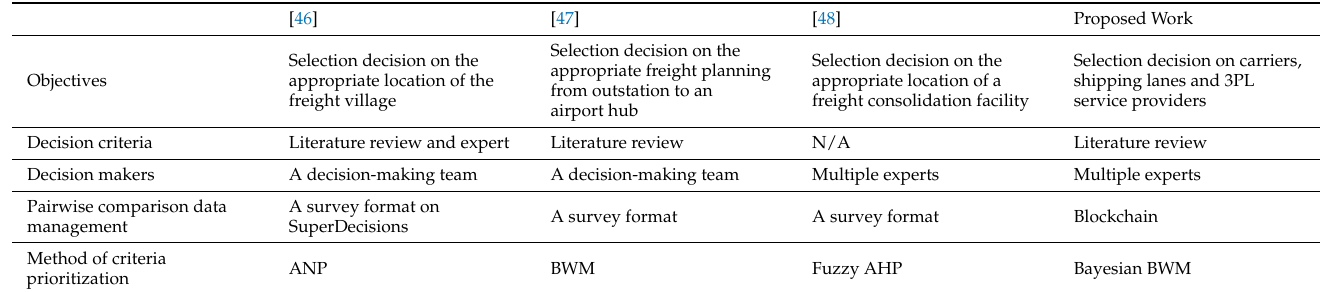
Table 7. Comparison summary between the proposed work and existing